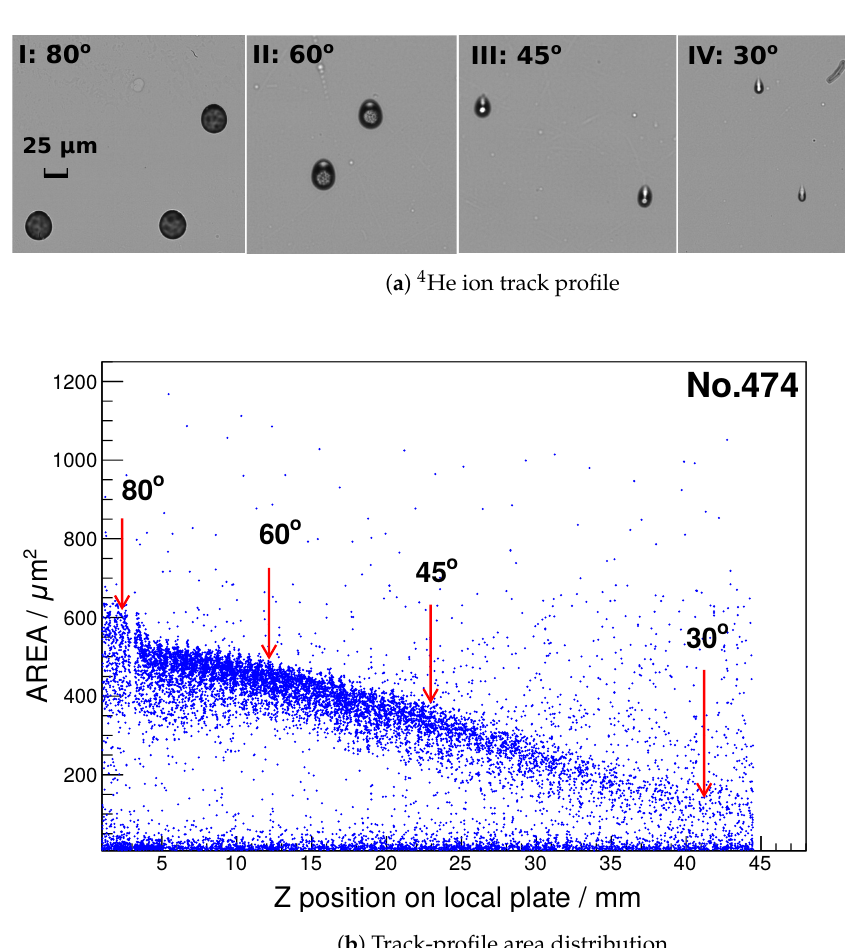
Figure 11. 4 He ion track profile and track AREA vs. polar angle. ( a ) The track profile images as seen in the snapshots under the scanning microscope. The tracks marked with polar angle are located on the center line of CR-39 plate ( Y = 0) as in Figure 9. ( b ) The distribution of track area vs. track position along Z axis shows a correlation with polar